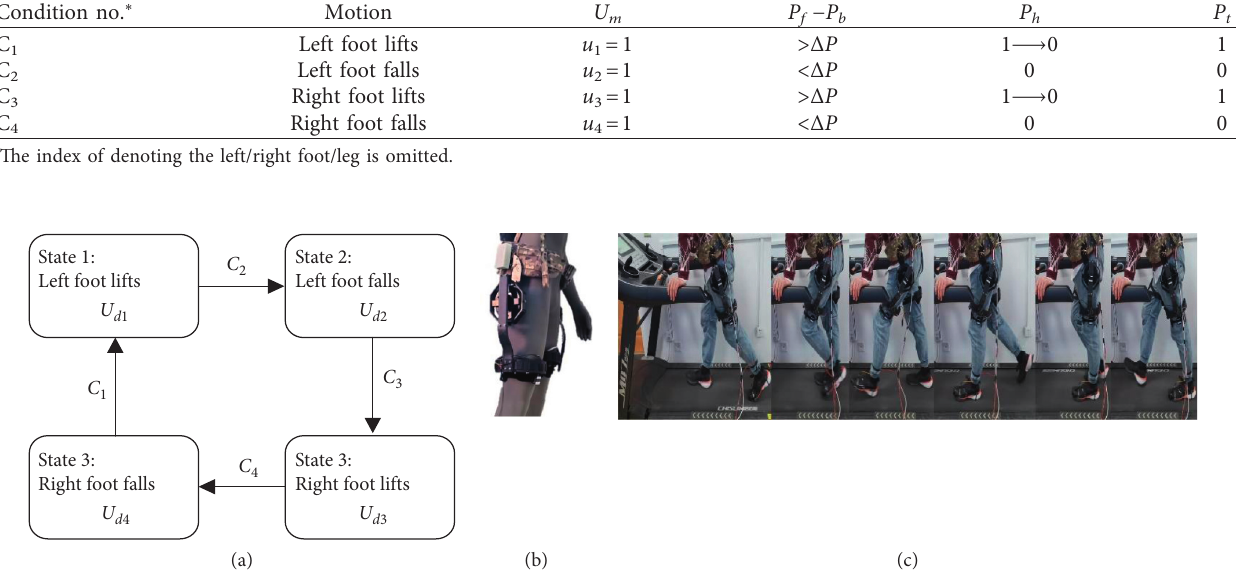
Figure 6: Experiment based on FSM. (a) State flow of FSM. (b) Exoskeleton. (c)